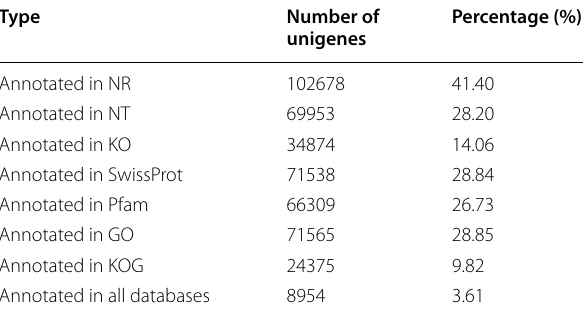
Table 1 Summary of the annotation about the E. agallocha transcriptome